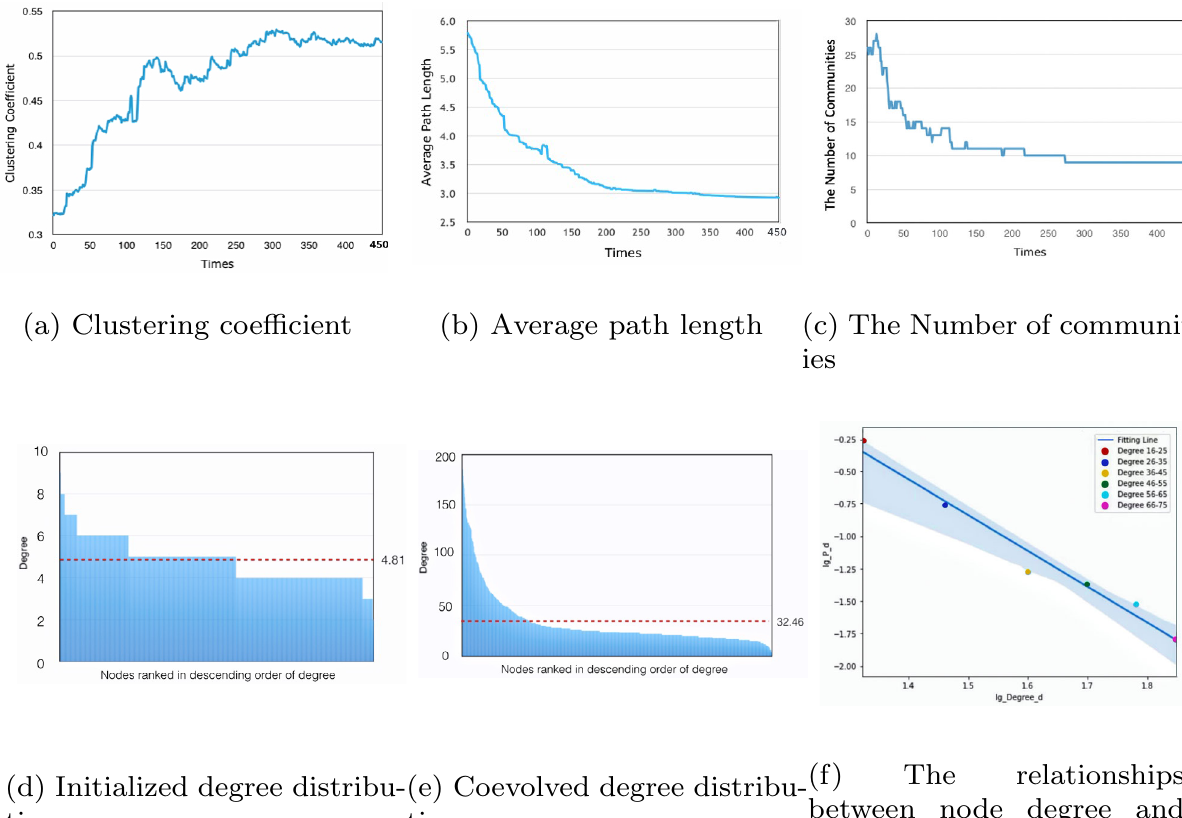
The relationships between node degree and node proportion